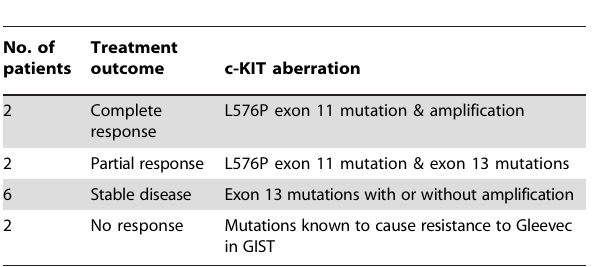
Table 3. Treatment outcomes related to specific c-KIT